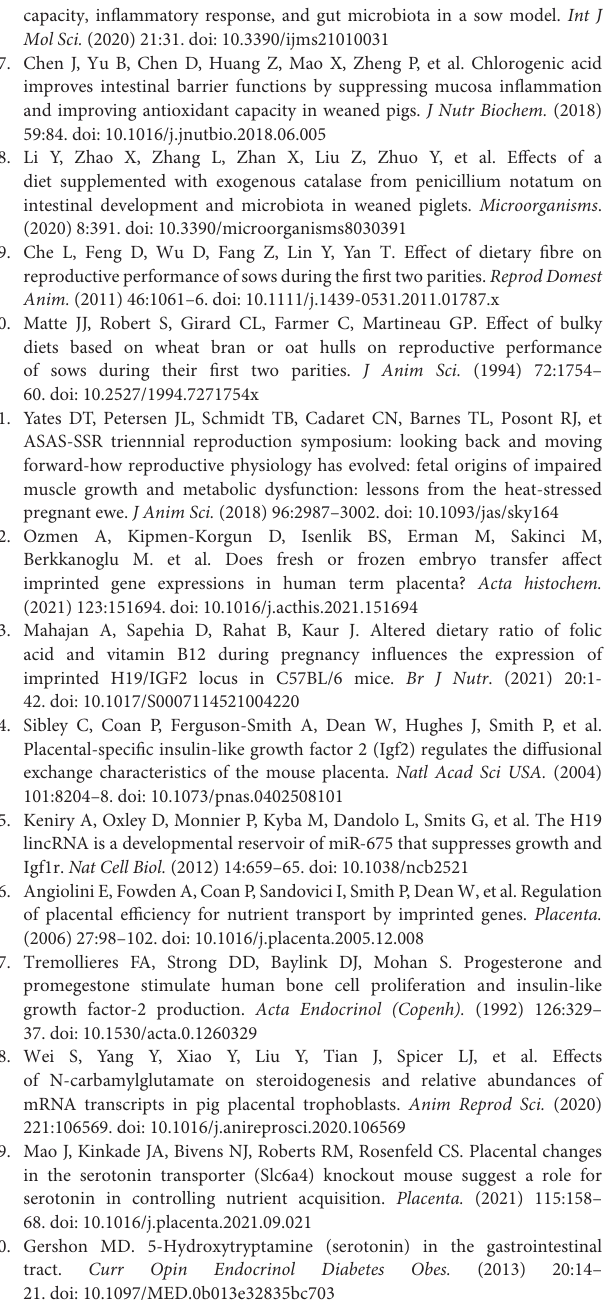
Supplementary Table S1 | The primer sequences of target genes and house-keeping